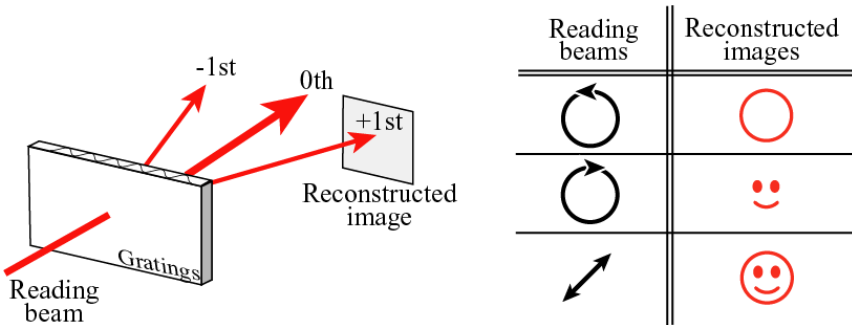
Figure 9. An example of image processing using multiplexed anisotropic grating